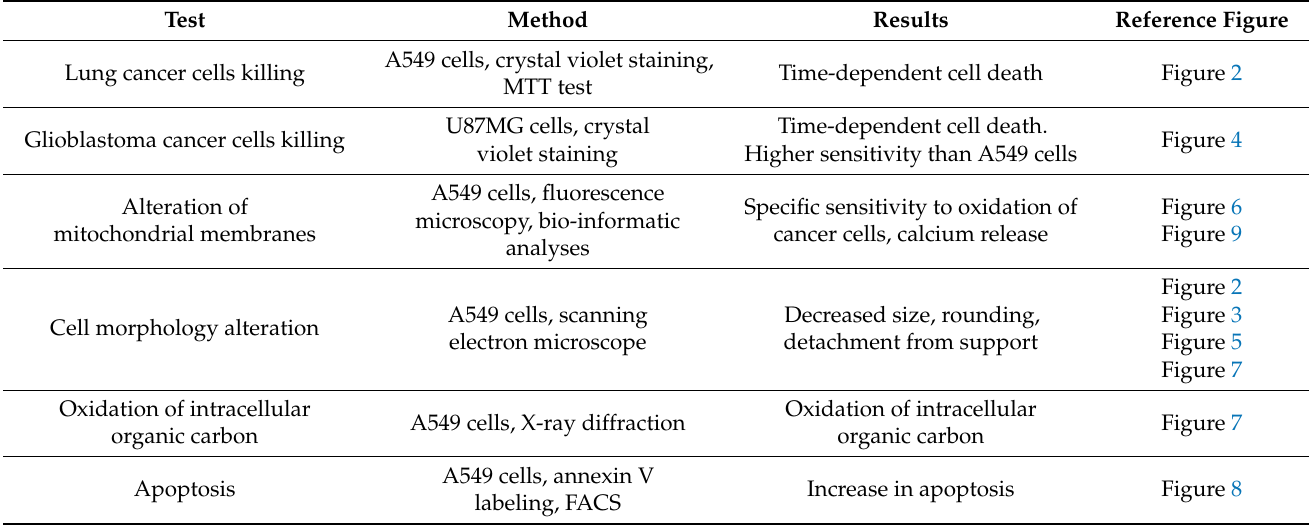
Table 1. Summary of results from in vitro experiments dealing the effect of ozonized oil at high ozonides (HOO) in cancer cells.